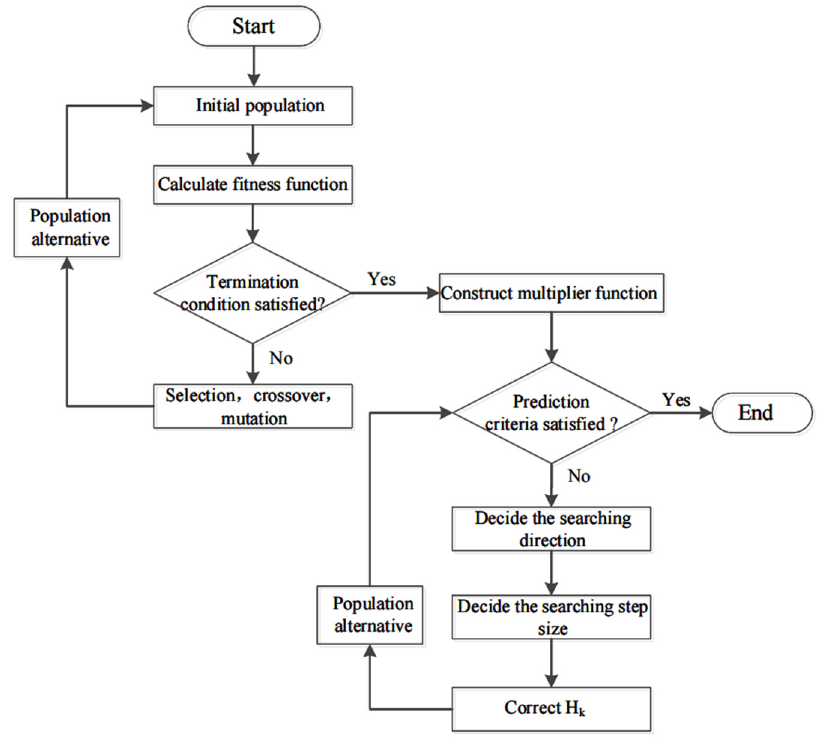
Figure 3. Flowchart of hybrid genetic algorithm.